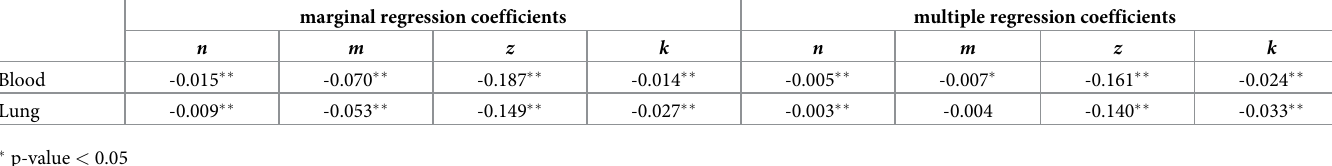
Table 1. Marginal and multiple regression coefficients for blood and lung cell type segmentation accuracy when varying number of any cell type with missing data ( n ), number of cell types in same lineage with missing data ( m ), whether examined cell type has missing data ( z ), and number of missing marks in examined cell type ( k